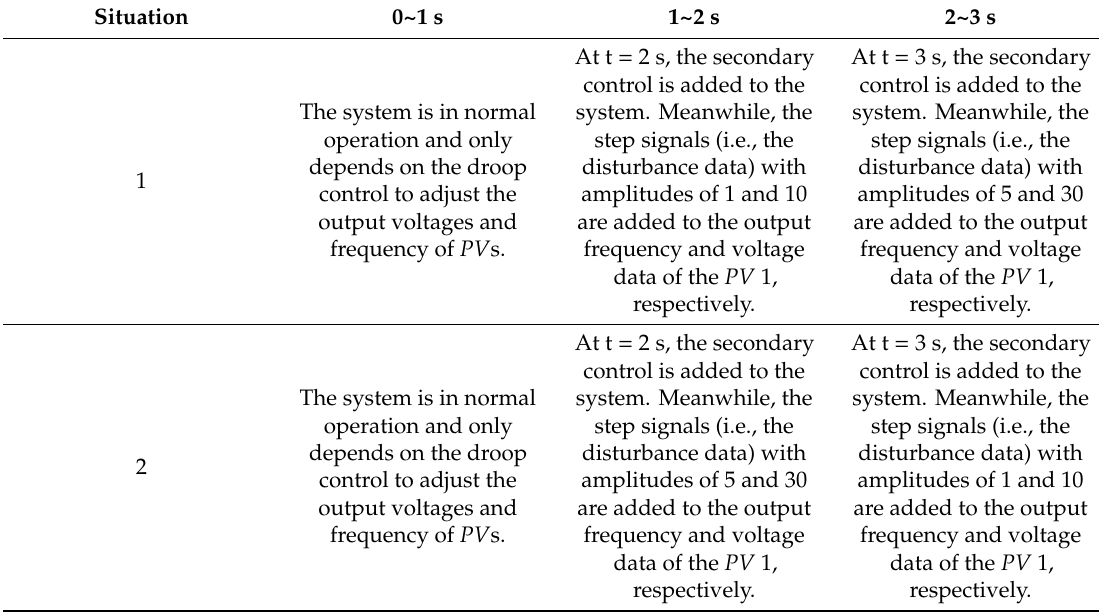
Table 4. The operation process in Case 2.